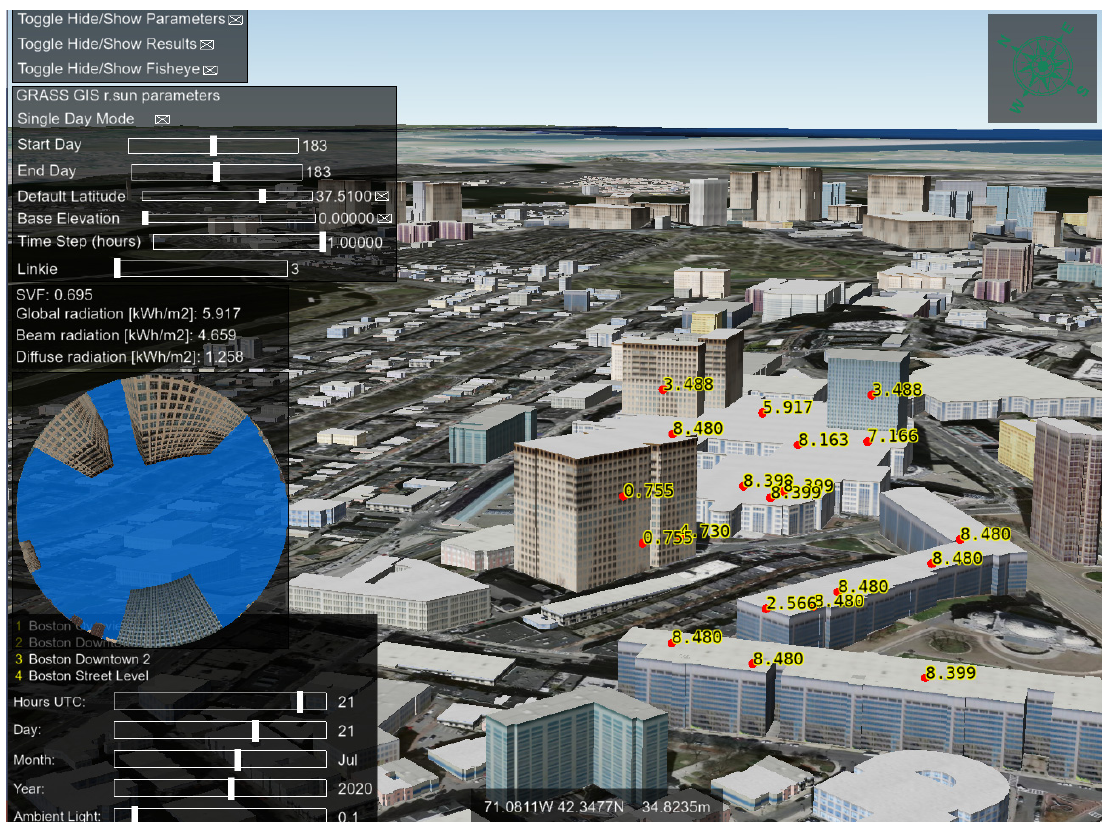
Figure 6. Calculating solar irradiation with a building footprint-extruded 3D-city model (Boston) overlaid on a basemap in Solar3D.